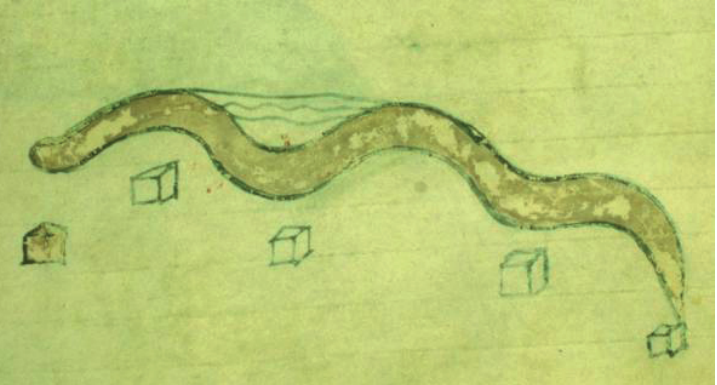
Figure 17. The topographical remanence of theoretical leaguestones on hydrographic network. © J. Bruant / Inrap.